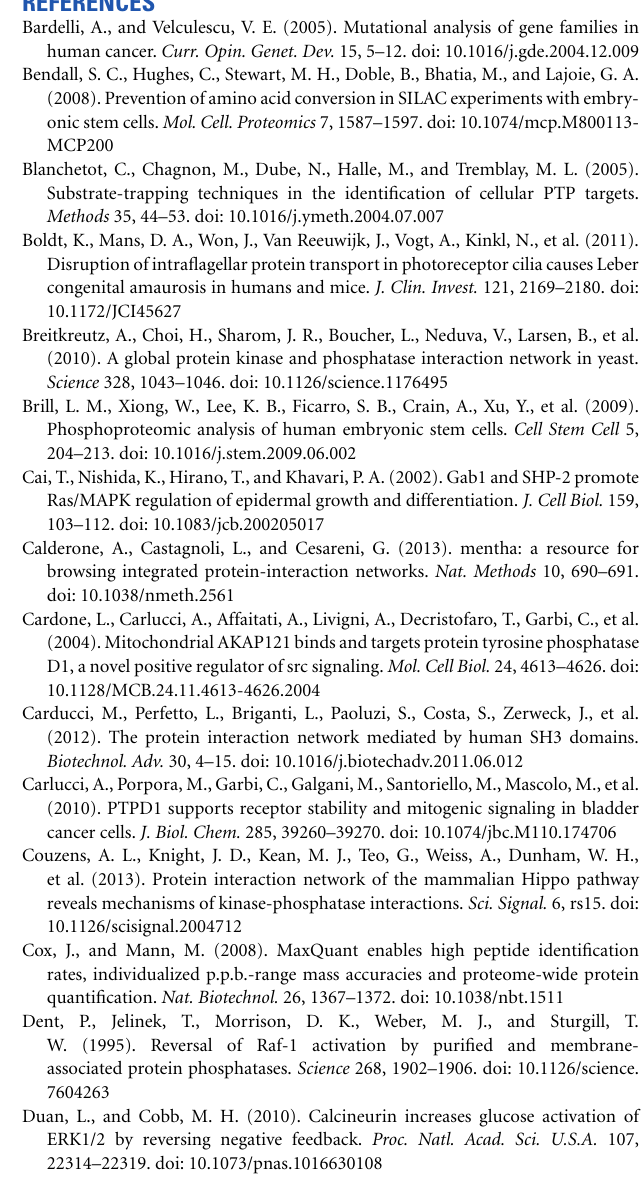
Table S5 | Experimental and literature extracted binary interactions, describing the paths from a phosphatase to its target in the RAS-PI3K